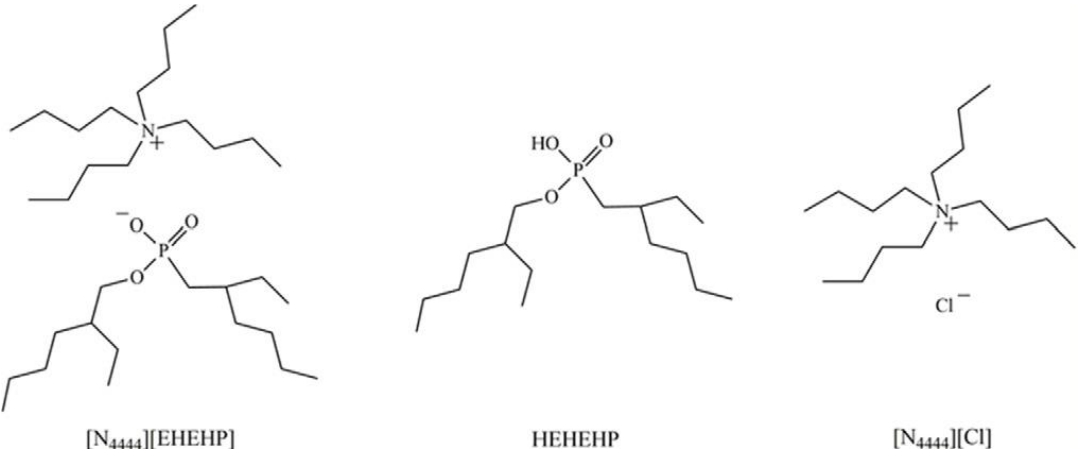
Figure 17. Chemical structures of ionic liquids [219]. Reprinted from Journal of Molecular Liquids, v. 304, Shi et al., Solvent extraction of lithium from aqueous solution using an ammonium ionic liquid, 112756, Copyright 2020, with permission from Elsevier.